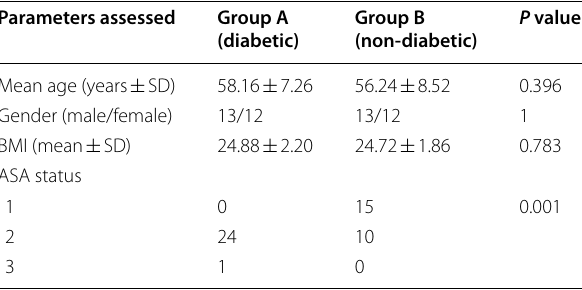
Table 1 Demographic parameters of included in study